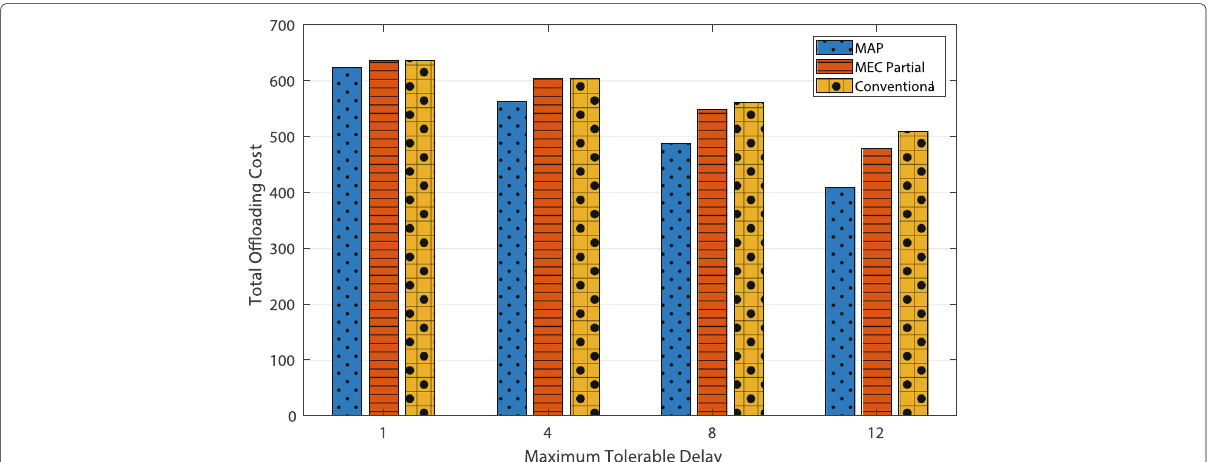
Fig. 5 The total offloading cost versus maximum tolerable delay t max , when RHVs=10 &